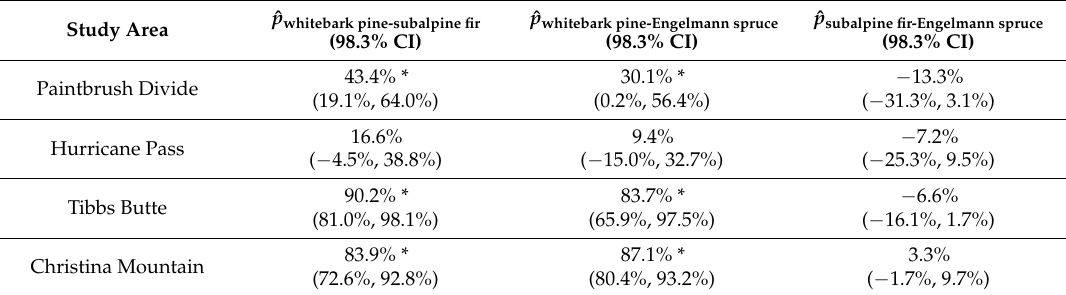
Table 3. Overall community composition mean difference parameter estimates.